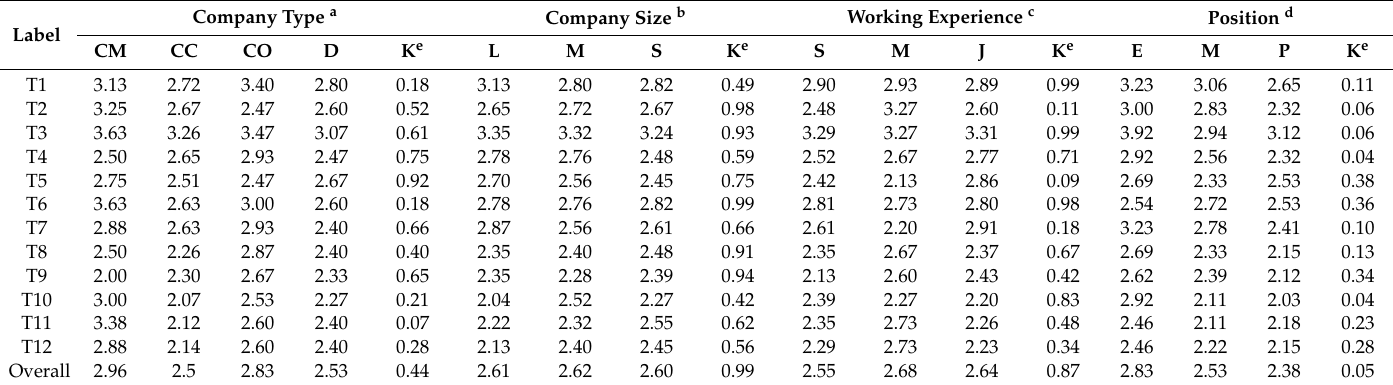
Table 5. Comparison of future investment level between di ff erent groups of